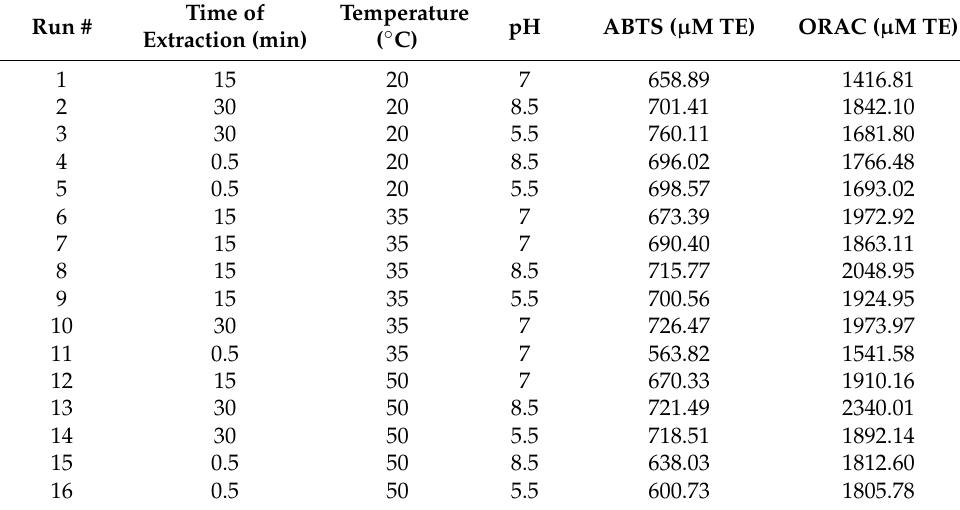
Table 4. Antioxidant activity ( µ M TE) measured by the ABTS and oxygen radical antioxidant capacity (ORAC) methods, obtained after ultrasound-assisted extraction at different times, temperatures and pH